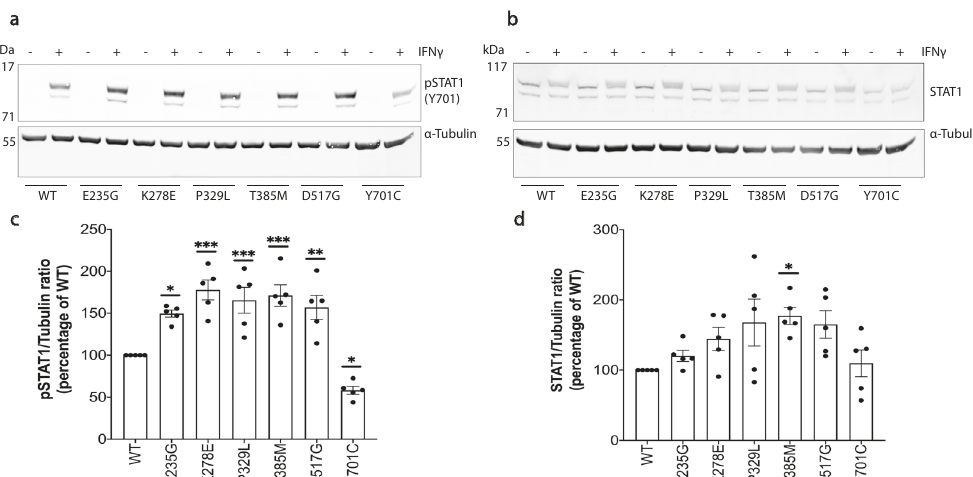
Fig. 2 Immunoblot analysis of pSTAT1 (Tyr701) and total STAT1 levels among STAT1 mutants following IFN γ stimulation. Levels of pSTAT1 ( a ) and total STAT1 ( b ) were measured in whole-cell protein lysates at baseline and following a 60-min stimulation with IFN γ (10 ng/mL), normalized to a loading control ( α -Tubulin). Densitometry analysis results from fi ve independent experiments were plotted for pSTAT1 ( c ) and STAT1 levels ( d ) following IFN γ stimulation and compared with WT. Results are presented as mean ± standard error of mean. Statistical analysis: one-way ANOVA with Dunnett ’ s post hoc test (* p < 0.05, ** p < 0.01, *** p < 0.001,**** p <